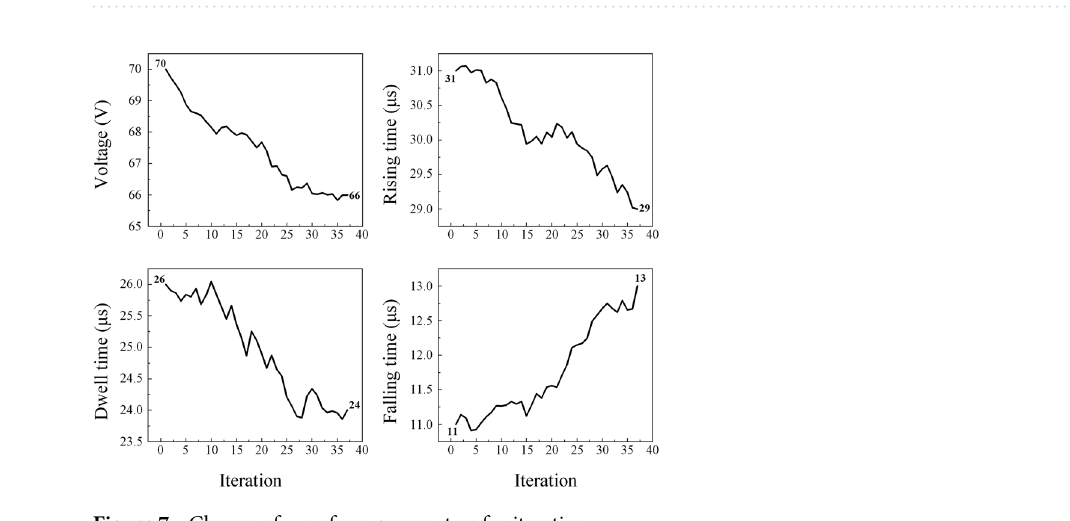
Figure 7. Change of waveform parameters for